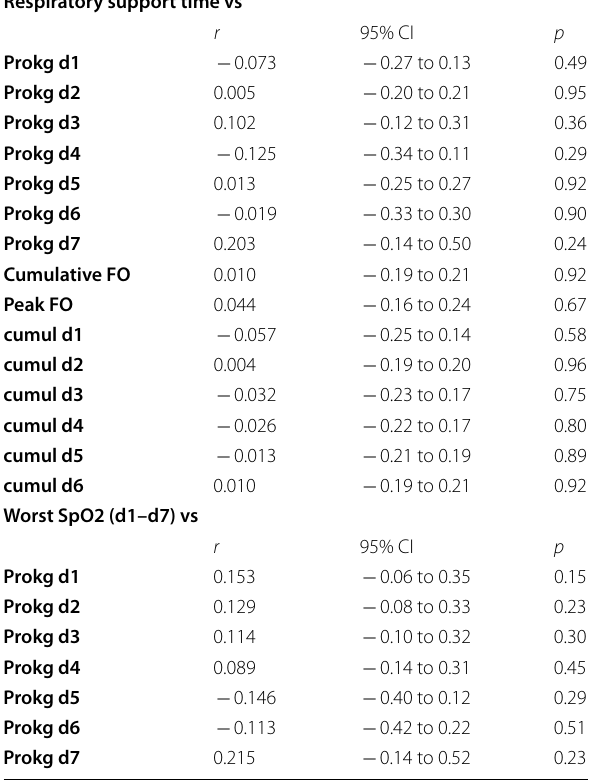
Table 2 Correlation of respiratory support time with daily fluid balance (prokg) from day 1 to day 7, cumulative fluid overload (FO), peak FO, cumulative fluid balances (cumul) from day 1 to day 7. Correlation of the worst pulse oxygen saturation (SpO2) recorded daily from day 1 to day 7 (d1–d7) with daily fluid balance (prokg) from day 1 to day